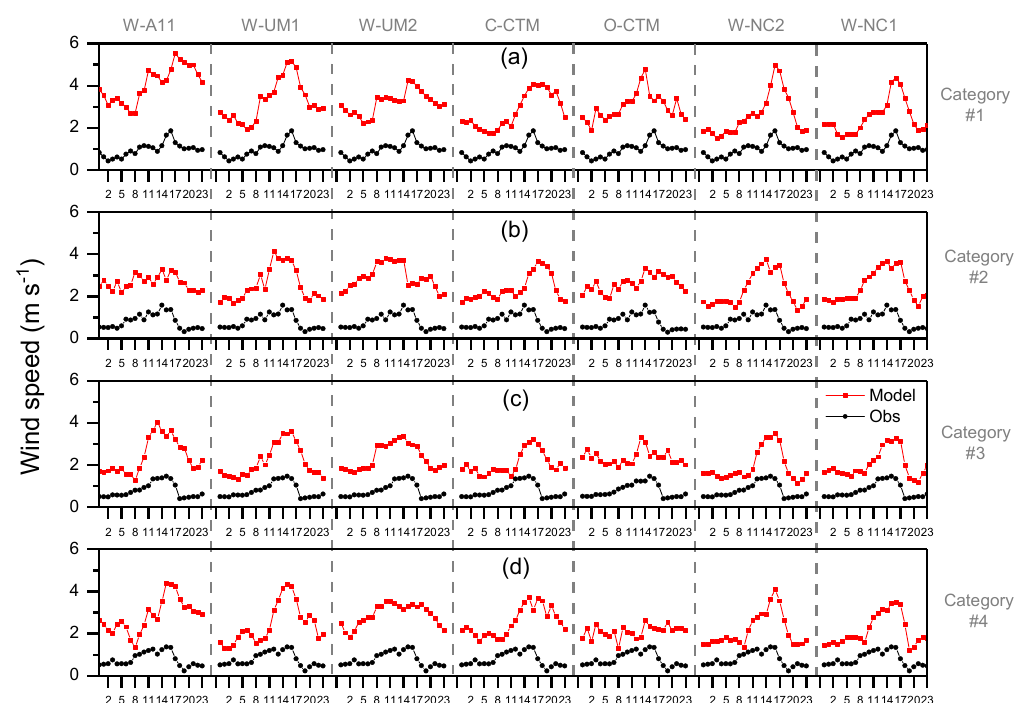
Figure 8. Diurnal composite observed and modelled 10 m wind speed at Westmead. Panels a—d represent each of the four radon-based mixing categories (Table 1).